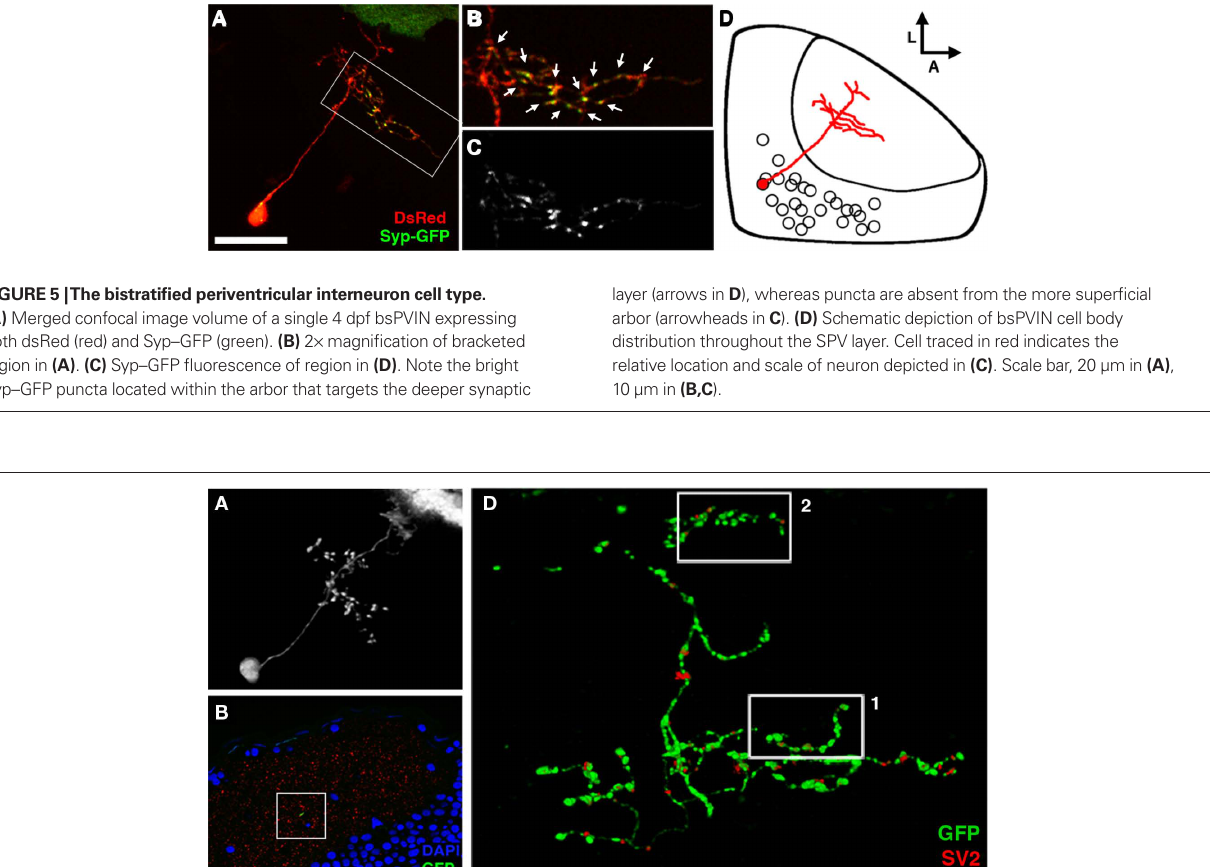
colocalized with areas of GFP labeling were included in rendering. Note large varicosities on the deeper SGC arbor and thin inter-varicosity neurites not detectable by laser-scanning microscopy in (A) . (e) 1.75 × magnification of boxed region 1 in (D) . (F) Forty-five degree rotation of region in (e) . Note that a majority of axonal varicosities contain distinct SV2 puncta. (G) 1.75 × magnification of boxed region 2 in (D) . Note that the majority of SV2 puncta are not